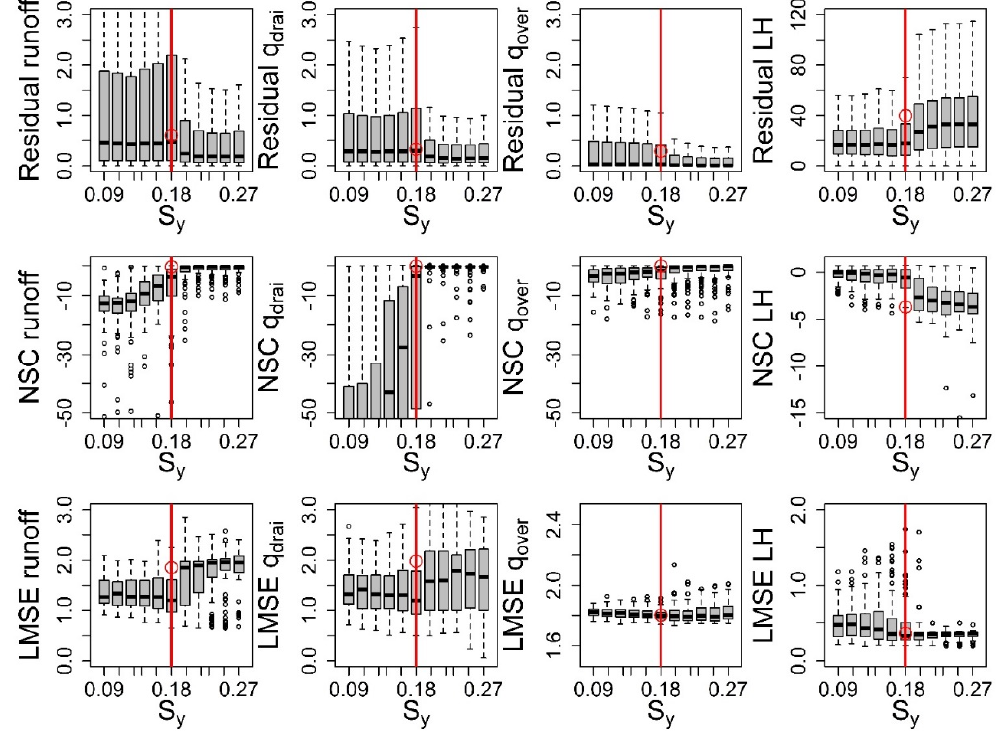
Figure 2. Boxplots for different response variables and metrics as a function of input parameters specific yield ( S y